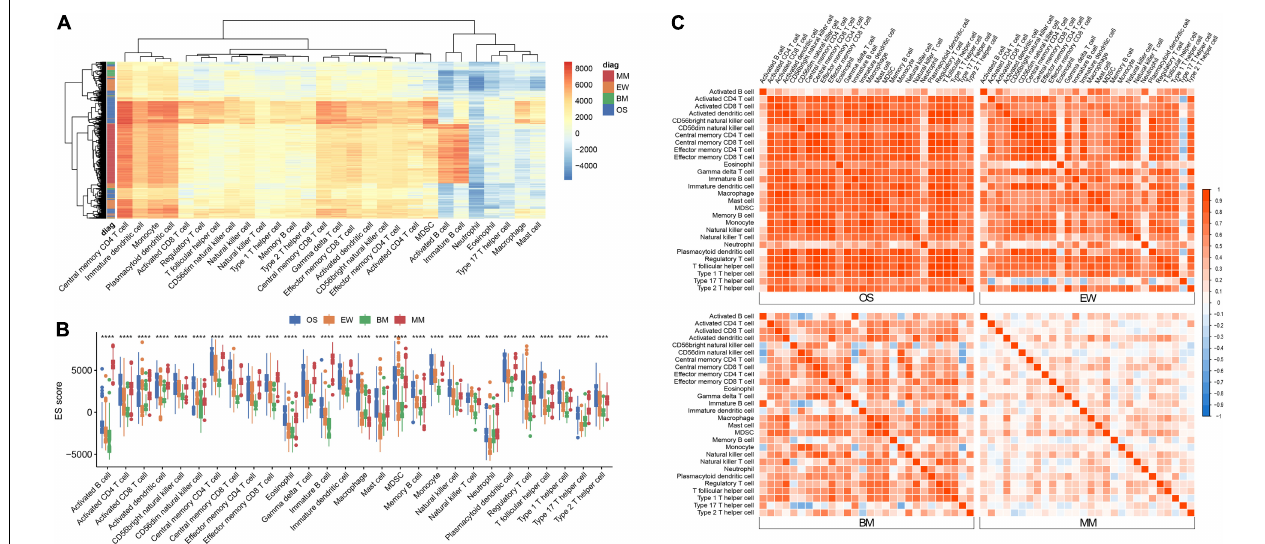
FIGURE 1 | Immune infiltration signature across four diseases. (A) Heatmap of ES score across all samples. (B) Boxplot of ES score grouped by tumor type; asterisk (*) denotes statistical significance examined by ANOVA test **** p < 0.0001. (C) Correlation matrix of ES score among the 28 cell types within each disease; red represents positive correlation, and blue represents negative correlation. MM, multiple myeloma; EW, Ewing’s sarcoma; BM, prostate cancer bone metastases; OS,